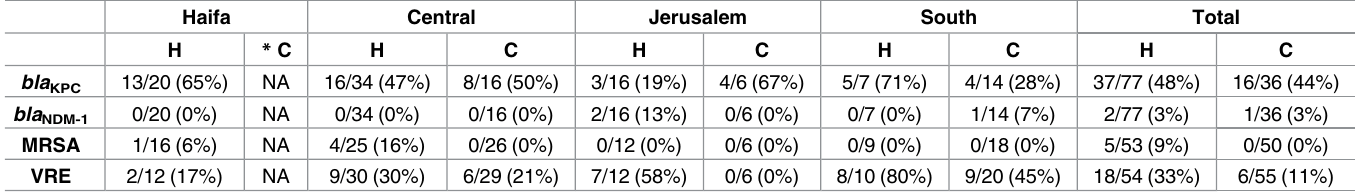
Table 2. Distribution of the pan-resistant isolates in the different sampling locations in Israel.